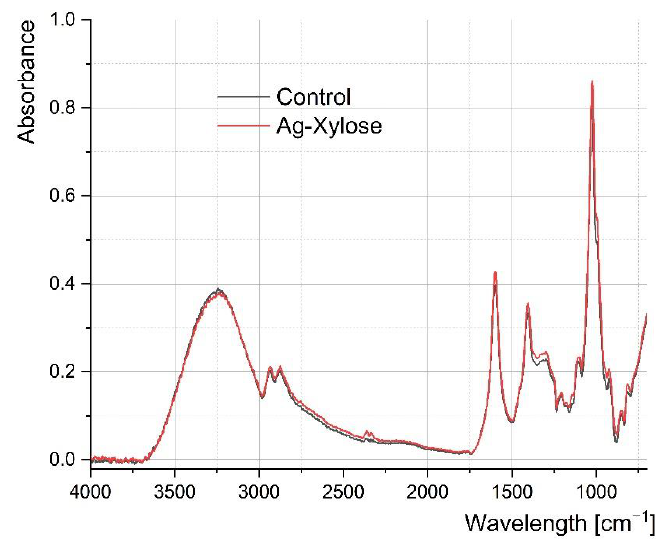
Figure 2. SEM micrographs of AgNPs taken at ×50,000 magnification.